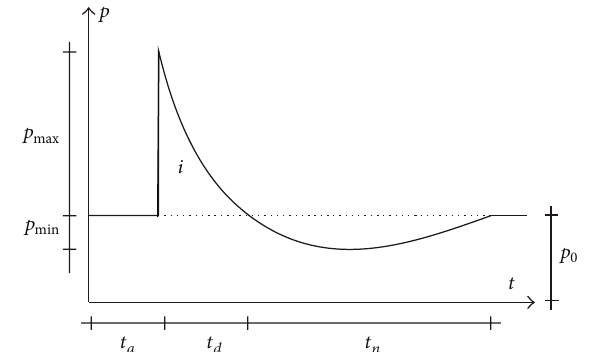
Figure 4: Pressure history for a free-field air-blast wave.